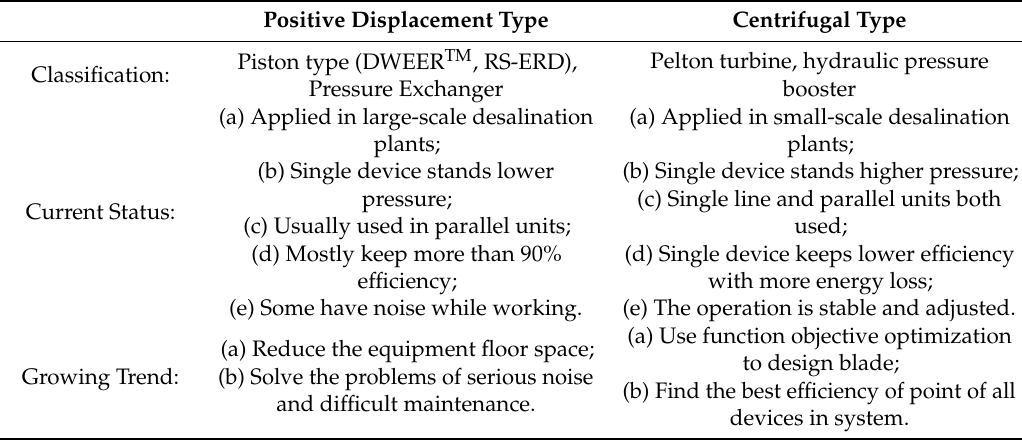
Table 9. Comparison and conclusion of energy recovery